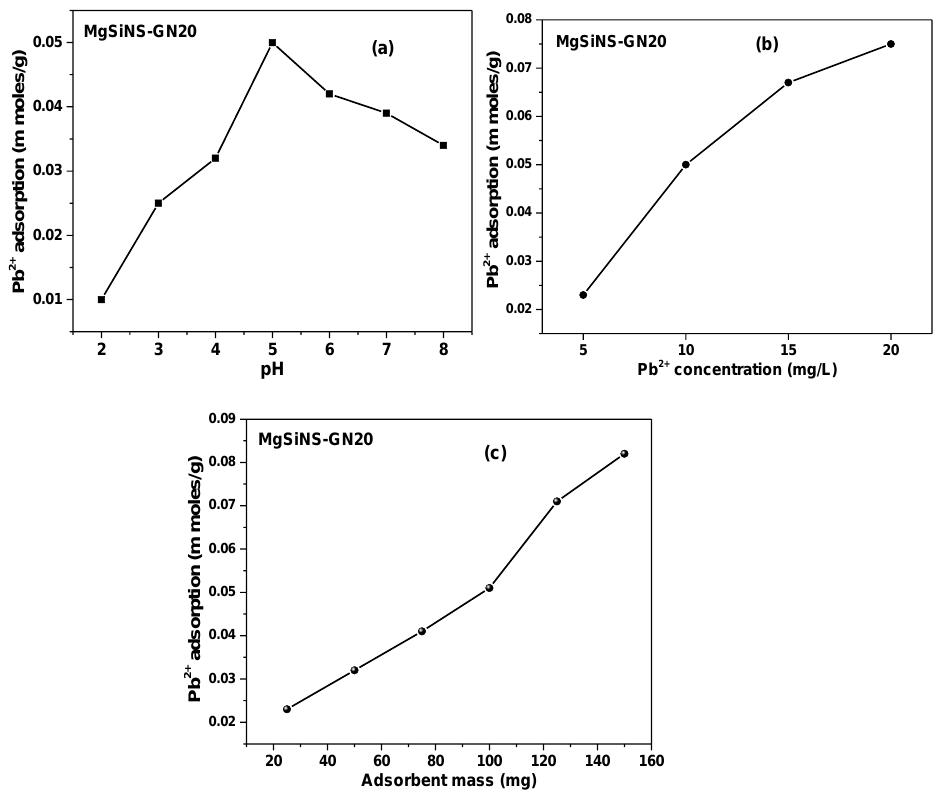
Fig. 11 : (a) Influence of pH (b) Pb 2+ concentration (c) adsorbent mass on the Pb 2+ adsorption capacity of the MgSiNS-GN20 composite 481 Figure 11. ( a ) Influence of pH, ( b ) Pb 2+ concentration, and ( c ) adsorbent mass on the Pb 2+ adsorption capacity of the MgSiNS-GN20